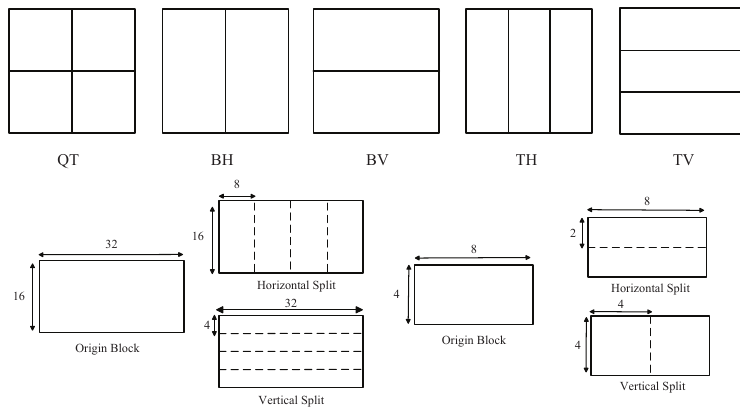
Figure 1. Five division modes of QTMT and two examples of